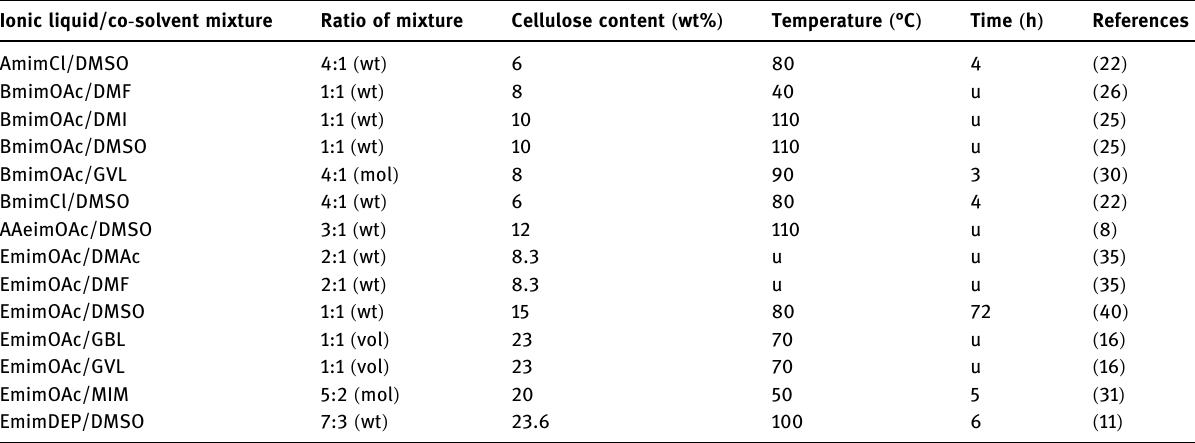
Table 5: Imidazolium - based ionic liquid/co - solvent mixtures, ratio of mixtures, cellulose contents, temperatures, and times for the dis - solution of cellulose